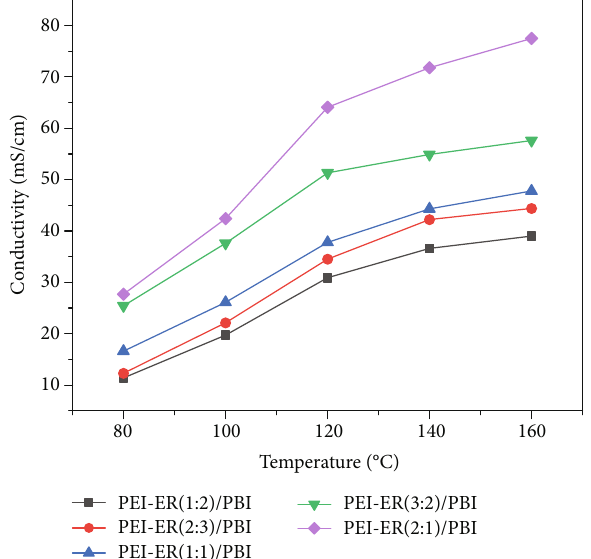
Figure 5: Proton conductivities of PA-doped PEI-ER/PBI membranes in anhydrous condition.